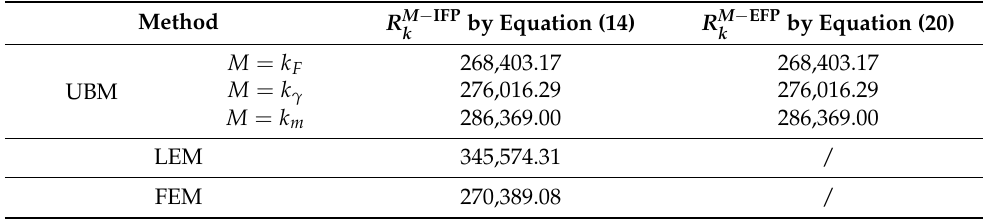
Table 8. Statistics of heterogeneous slope failure